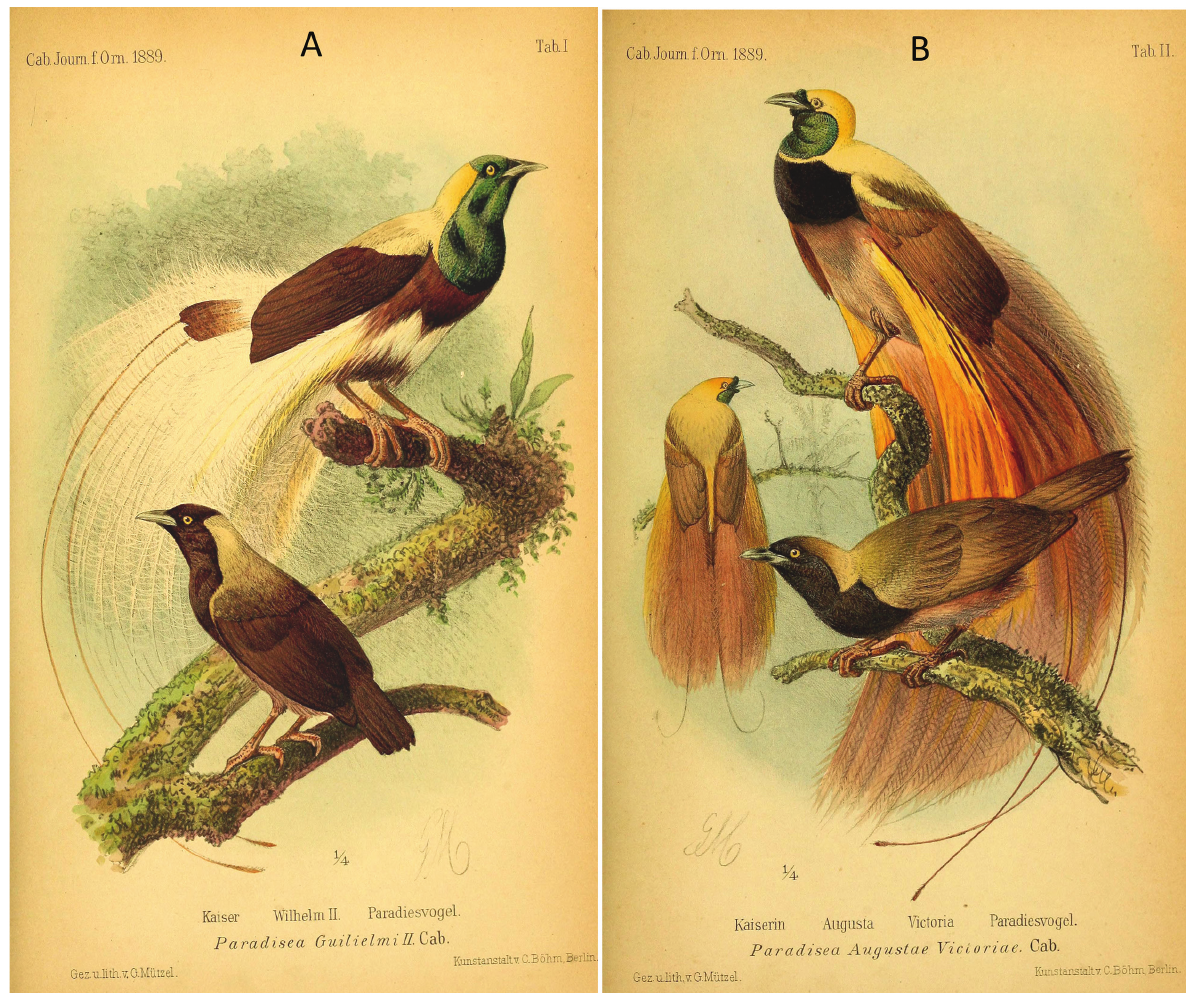
Figure 2. Plates of Paradisaea guilielmi ( A ) and P. raggiana augustaevictoriae ( B ), the presumed parental species of P. maria , related to the original descriptions by Cabanis (1888). Reproduced from the Biodiversity heritage library